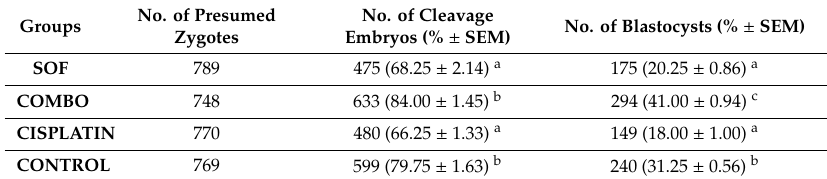
Table 3. Cleavage and developmental rates of embryos generated from oocytes with various media compositions.